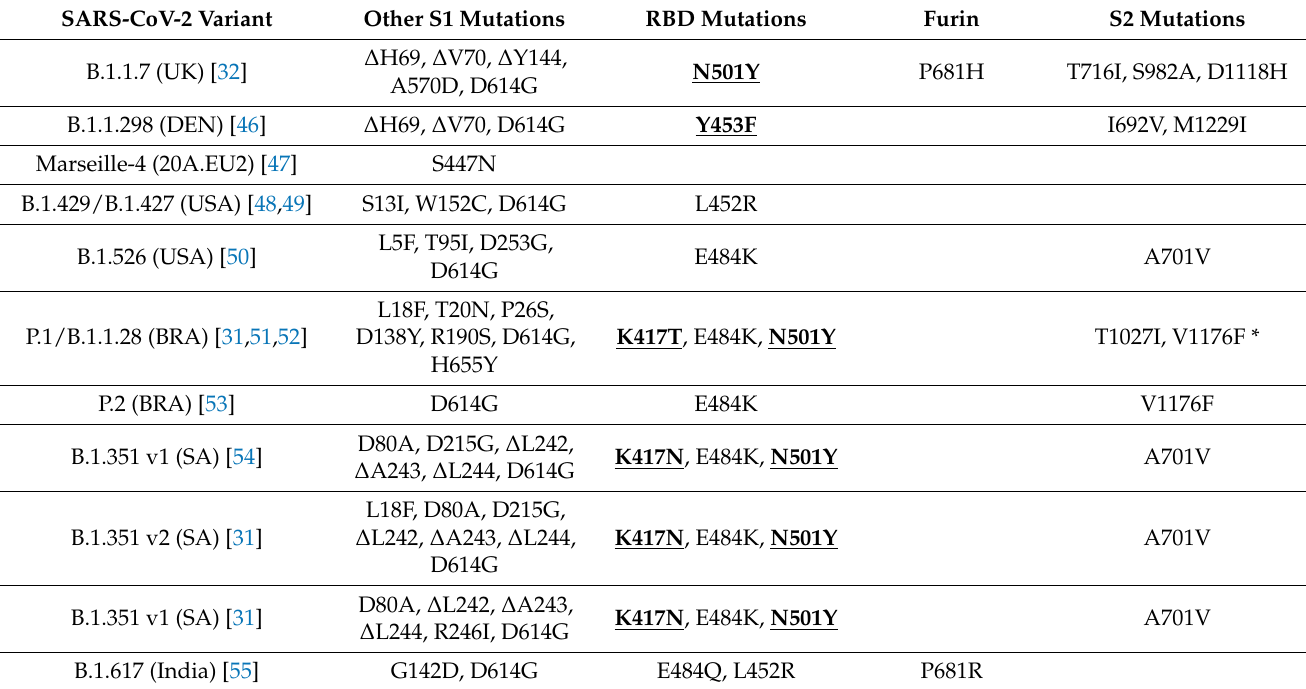
Table 1. SARS-CoV-2